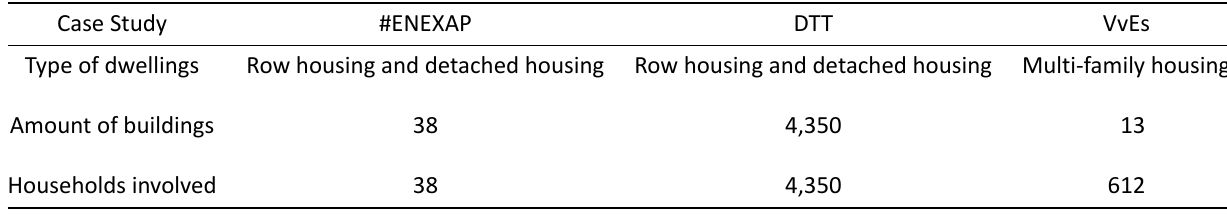
Table 1. Case study